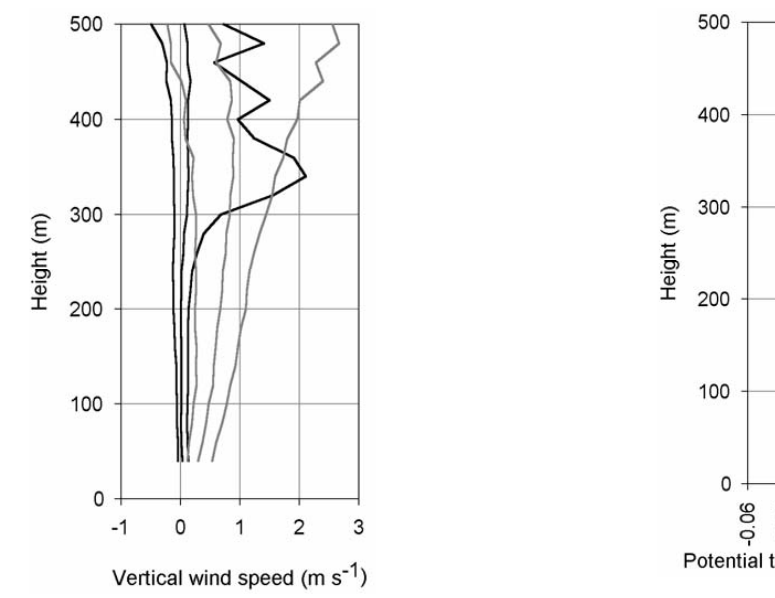
Fig. 3 . First, second and third quartiles of potential temperature gradient during the day (in grey) and night (in black).